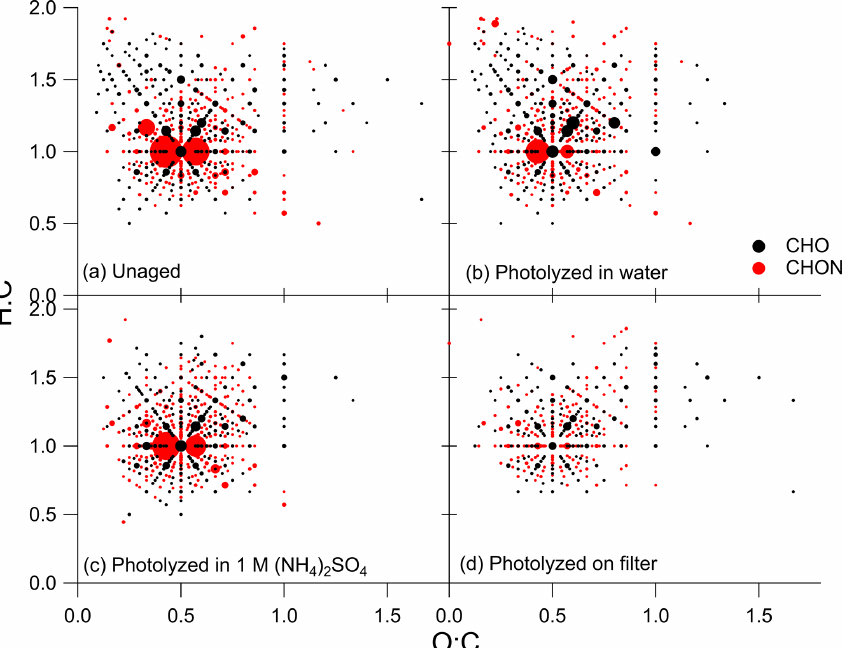
Figure 5. Van Krevelen diagrams for the (a) unaged sample from Filter 3, (b) sample photolyzed in water from Filter 3, (c) sample photolyzed in 1M ammonium sulfate from Filter 4, and (d) sample photolyzed on the filter from Filter 3. CHO formulas are shown in black, and CHON formulas are shown in red. The size of the marker represents the summed mass spectrometry abundance of all CHO or CHON compounds with the corresponding H:C and O:C ratios, and all points with intensities less than 1% of the maximum intensity in the unaged sample are excluded. Control (dark aged) Van Krevelen diagrams and all points excluded here are shown in Figs. S10 and